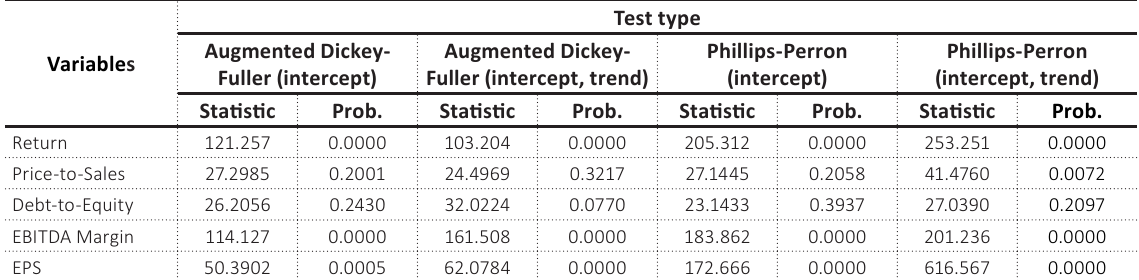
Table 4. Stationarity test results for all variables